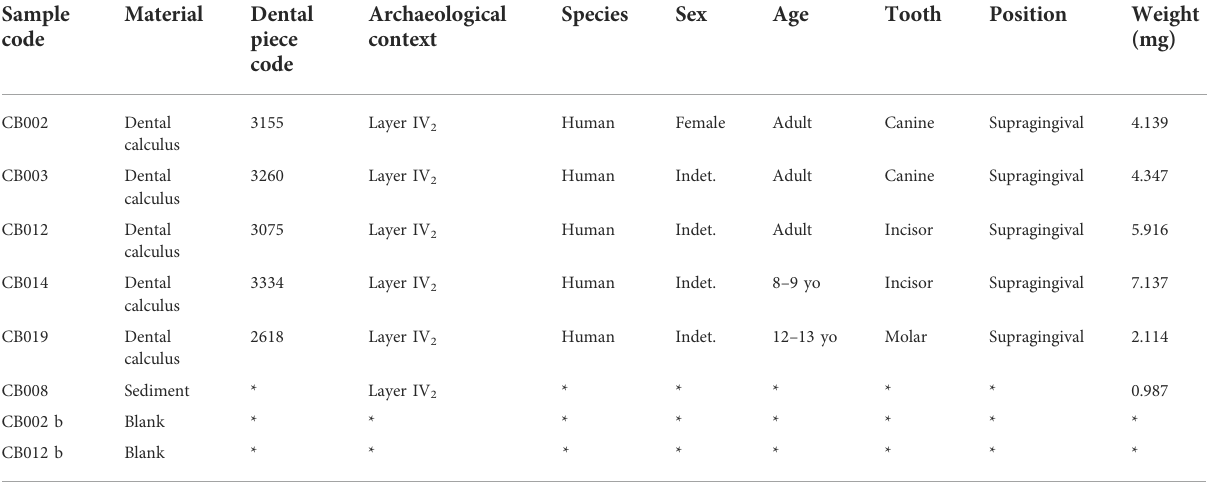
TABLE 2 Cova Bonica dental calculus samples taken for microremain microscopic